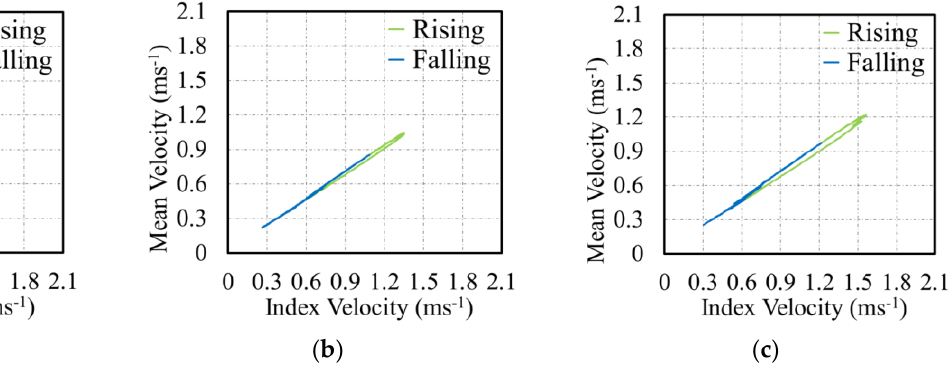
Figure 11. The graphical representation of the IVRC one-to-one regression equation for the storm events analyzed in Figure 8a, 8b, and 8c, respectively. ( a ) Event #24 (2015); ( b ) Event #60 (2018); ( c ) Event #50 (2017).